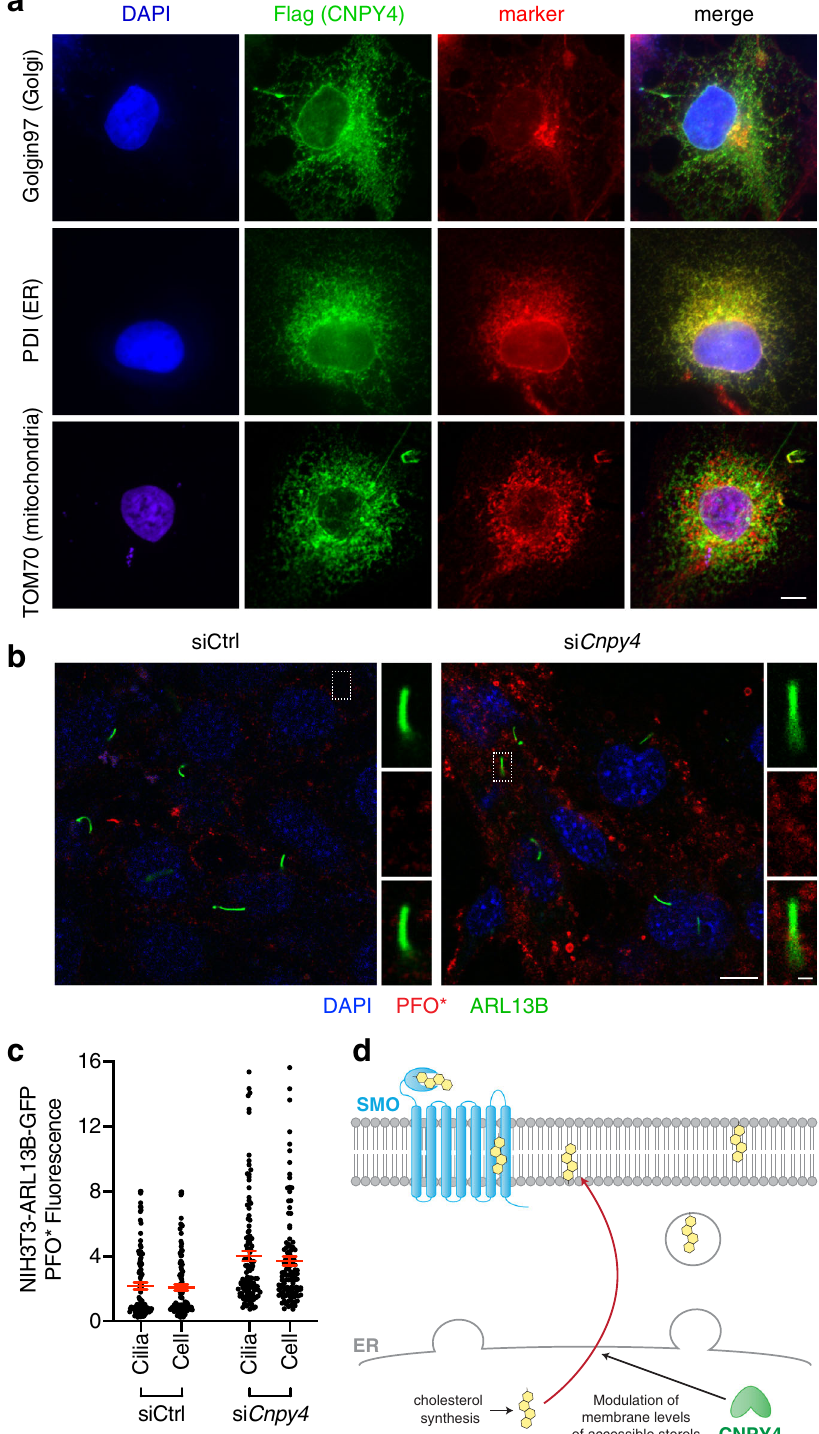
Fig. 5 CNPY4 is an ER-resident protein that elevates membrane levels of accessible cholesterol. a Immuno fl uorescence-based staining of CNPY4 (Flag, green), organelle markers (indicated antibody, red), and nuclei (DAPI, blue) in COS-7 cells transiently transfected with Flag-tagged human CNPY4. The scale bar represents 10 μ m. b Immuno fl uorescence-based staining of primary cilia (ARL13B-GFP, green), accessible cholesterol (PFO*-AF647, red), and nuclei (DAPI, blue) in ciliated NIH3T3 cells stably expressing ARL13B-GFP, treated with control or Cnpy4 siRNA. The scale bar represents 10 μ m. Cilia scale bar represents 1 μ m. c Quanti fi cation of PFO* fl uorescence intensity at the cilia and in the rest of the cell as described in the “ Methods ” section. Data represent the mean ± SEM ( n = 104 siCtrl cells and n = 116 for si Cnpy4 cells from three independent experiments). d Schematic illustrating proposed model of CNPY4 modulation of HH activation. CNPY4, an ER-resident protein, regulates the ability of unbound sterols synthesized in the ER to be expressed at cell membrane, thus controlling the activation of